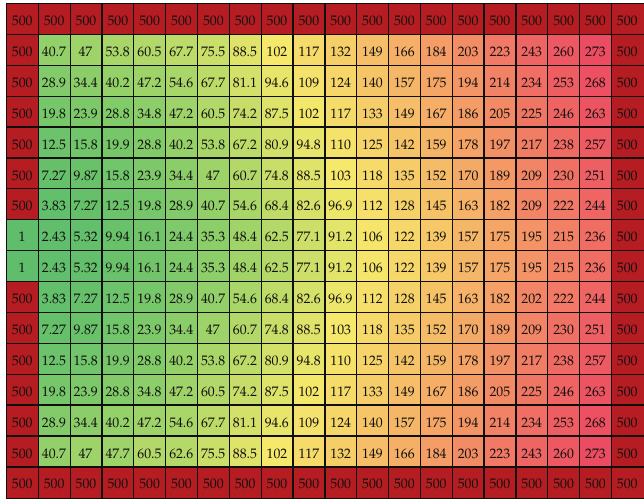
Figure 5: Floor-field values generated using the proposed model for a room with a central exit in the left